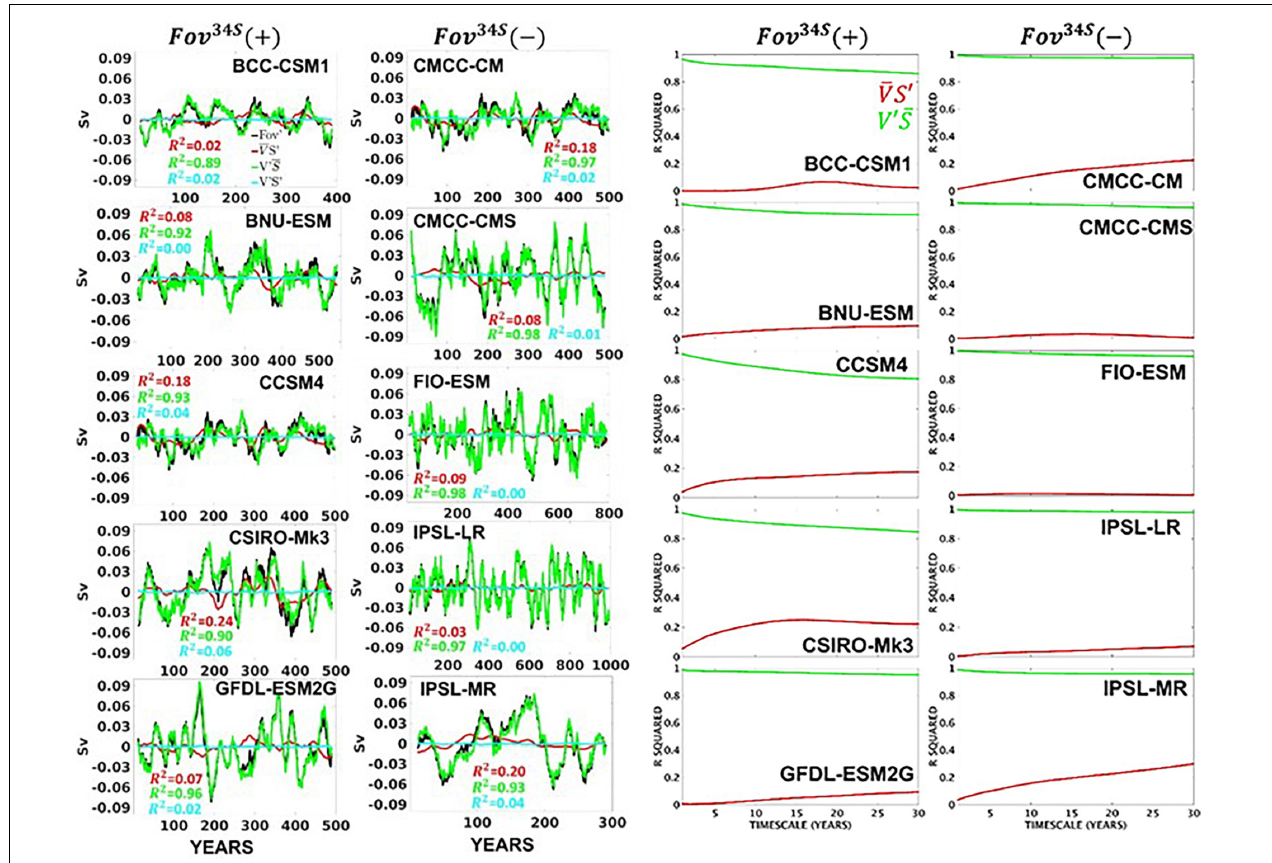
FIGURE 5 | (Left) : As in Figure 4 but for F ov (cid:48) averaged between 26 ◦ N and 40 ◦ N. The column headings are only used to classify the models into the two groups.